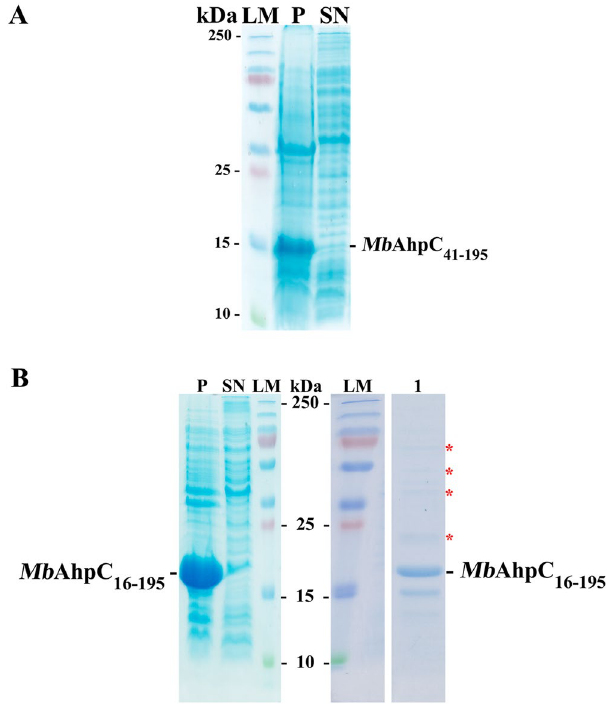
Figure 4. Importance of N-terminal residues. ( A ) Solubility assay of Mb AhpC 41–195 showed low solubility of the protein as reflected in the pellet, labelled as P. SN represents supernatant. ( B ) Mb AhpC 16–195 also showed a less soluble protein ( left ) and the presence of a laddering pattern ( right ) in the 125 mM imidazole fraction after affinity chromatography, indicates the presence of undefined oligomers. LM represents a molecular weight standard. Both SDS gels revealed the importance of the N-terminal residues, particularly from residues 1–15, in maintaining the solubility and oligomerization of Mb